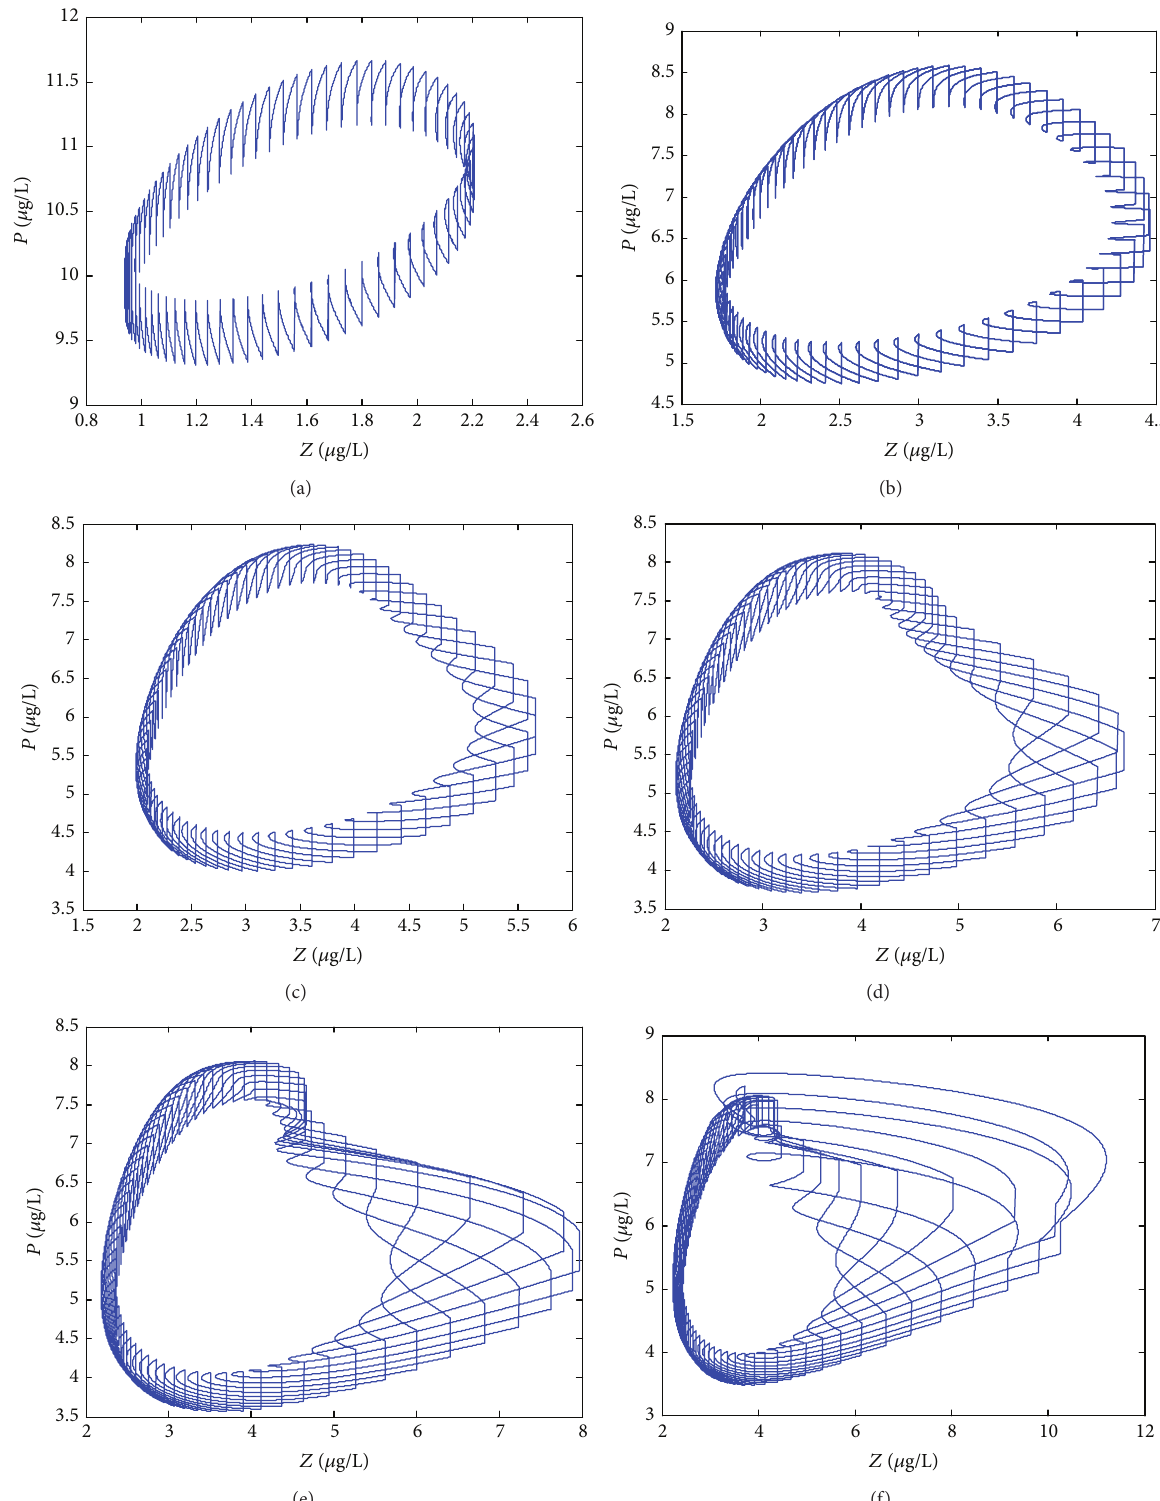
Figure 4: Phase portraits of system (3) with initial values (𝑃(0),𝑍(0)) = (2,5) when 𝜇 = 0.012 and 𝑄 = 0.5 . (a) 𝜏 = 5 , (b) 𝜏 = 15 , (c) 𝜏 = 25 , (d) 𝜏 = 35 , (e) 𝜏 = 45 , and (f) 𝜏 = 55